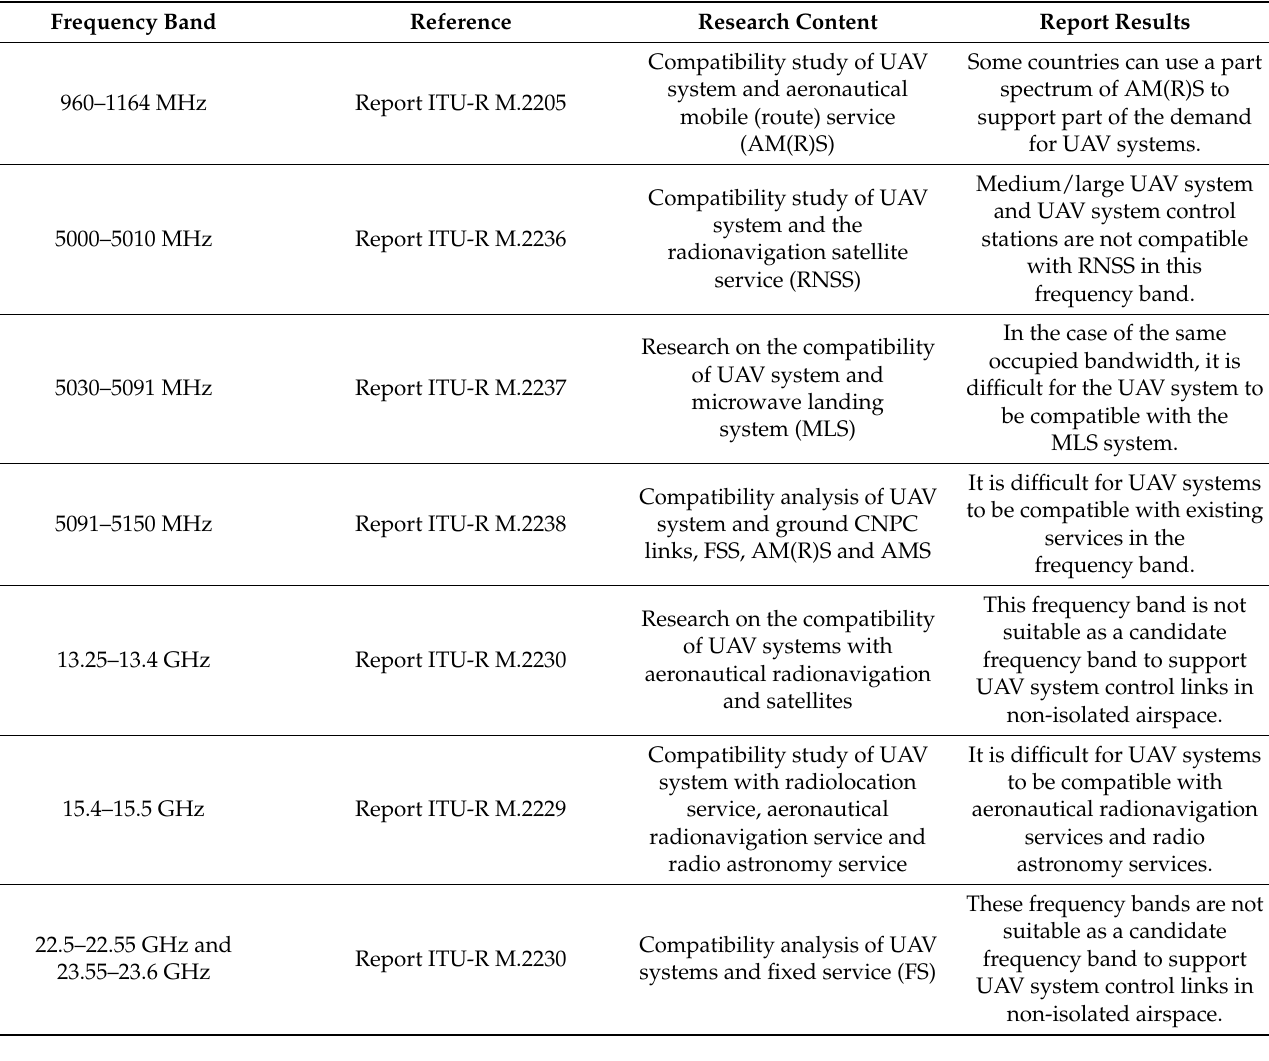
Table 2. ITU’s studies on the compatibility of UAVs and other services.